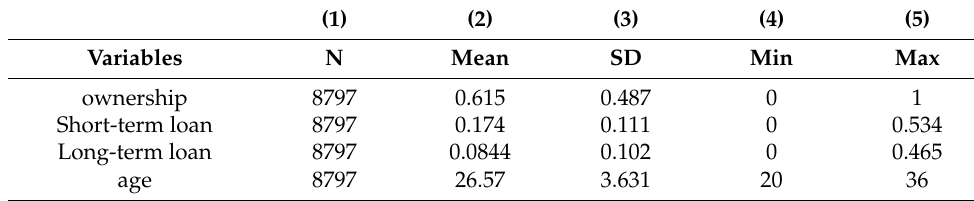
Table 4. Descriptive statistics for each